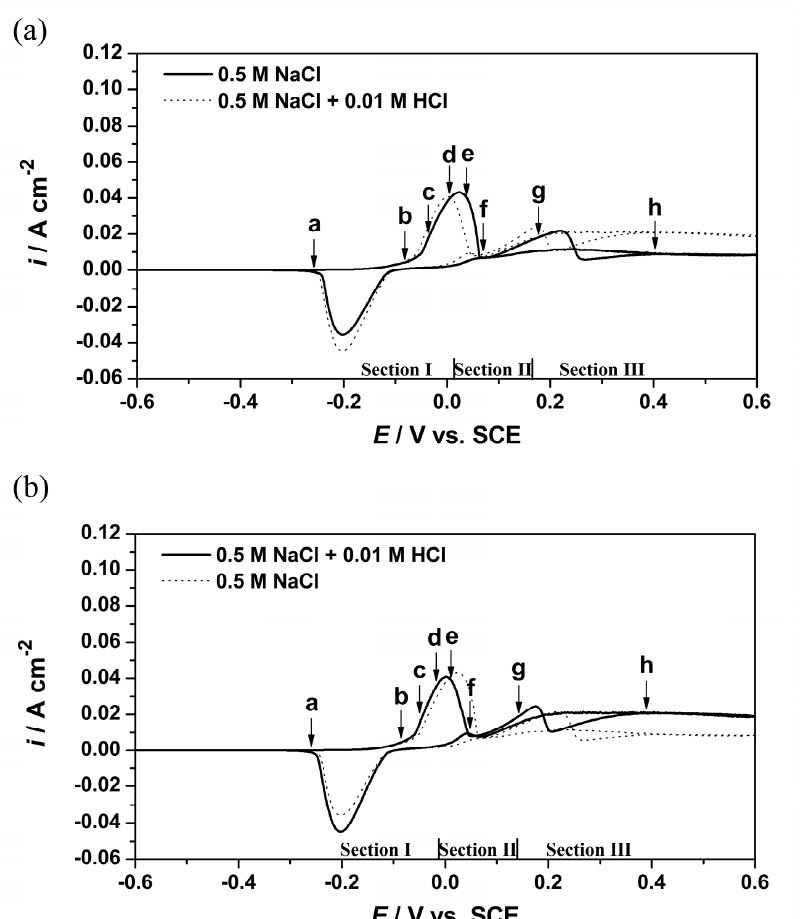
Figure 3. The cyclic voltammograms of the copper electrode in acidic and neutral NaCl solutions at 10 mV · s − 1 . ( a ) 0.5 M NaCl solution. ( b ) 0.5 M NaCl + 0.01 M HCl solution.